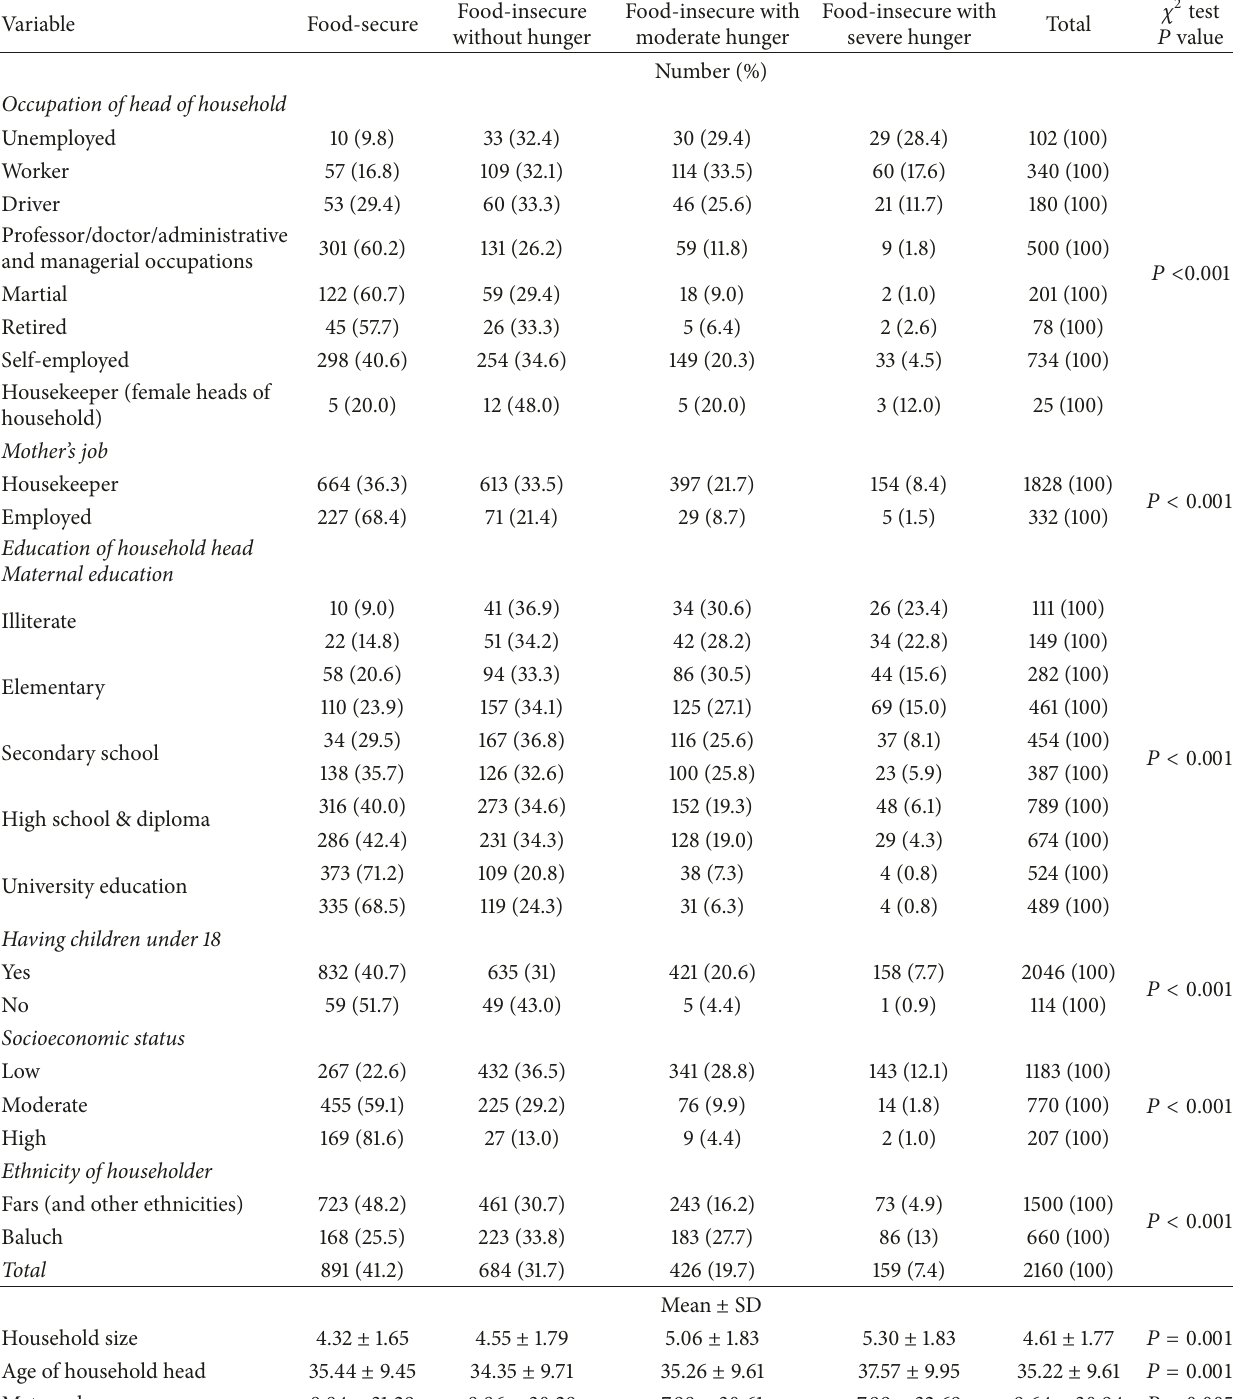
Table 1: Associations between household food insecurity and socioeconomic and demographic variables in the households studied ( 𝑛 = 2160